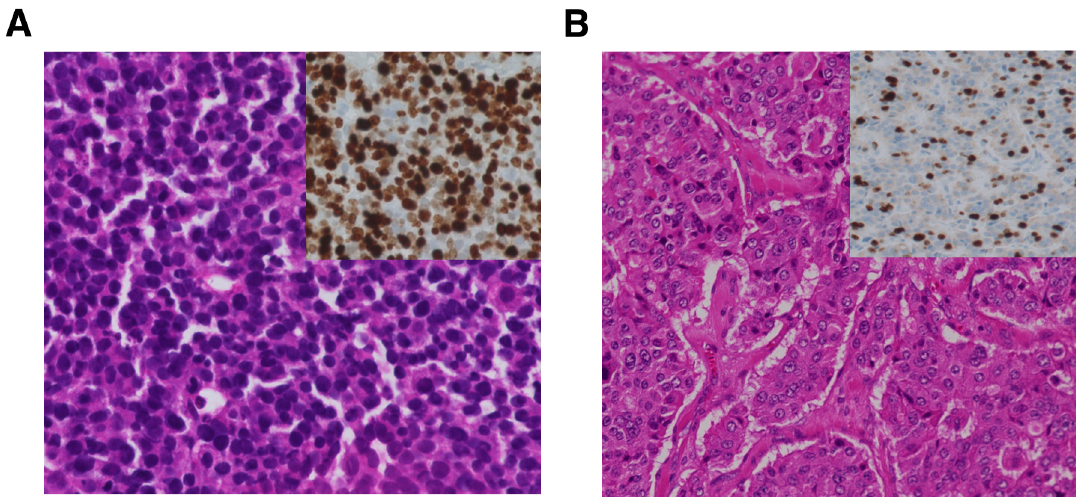
Figure 1. Histopathological features of poorly differentiated small cell carcinoma and well-differentiated NET G3. ( A ) In small cell carcinoma, tumor cells with a high nuclear cytoplasmic ratio and small-sized ovoid nuclei grow in a solid pattern. Immunohistochemical analysis shows extremely high Ki-67 labeling index values (hematoxylin and eosin, and Ki-67 immunohistochemical staining, original magnifications ×400). Ki-67 immunohistochemical staining is shown in the upper right corner; ( B ) in NET G3, tumor cells with a moderate amount of cytoplasm and a low mitotic rate show a trabecular and glandular growth pattern. The Ki-67 labeling index is over 20%, but is not as high as that of small cell carcinoma (hematoxylin and eosin, and Ki-67 immunohistochemical staining, original magnifications ×200). Ki-67 immunohistochemical staining is shown in the upper right corner.